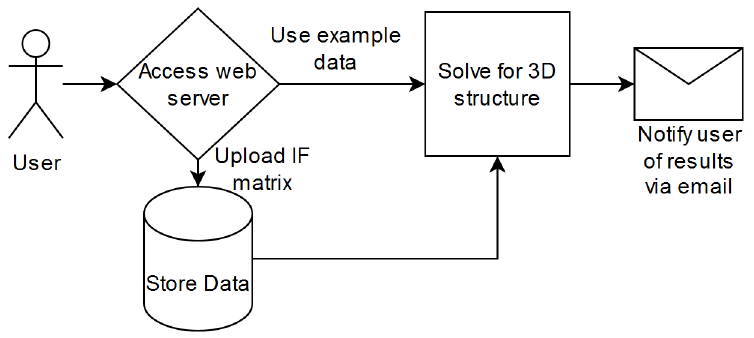
Figure 3. Standard expected use case.